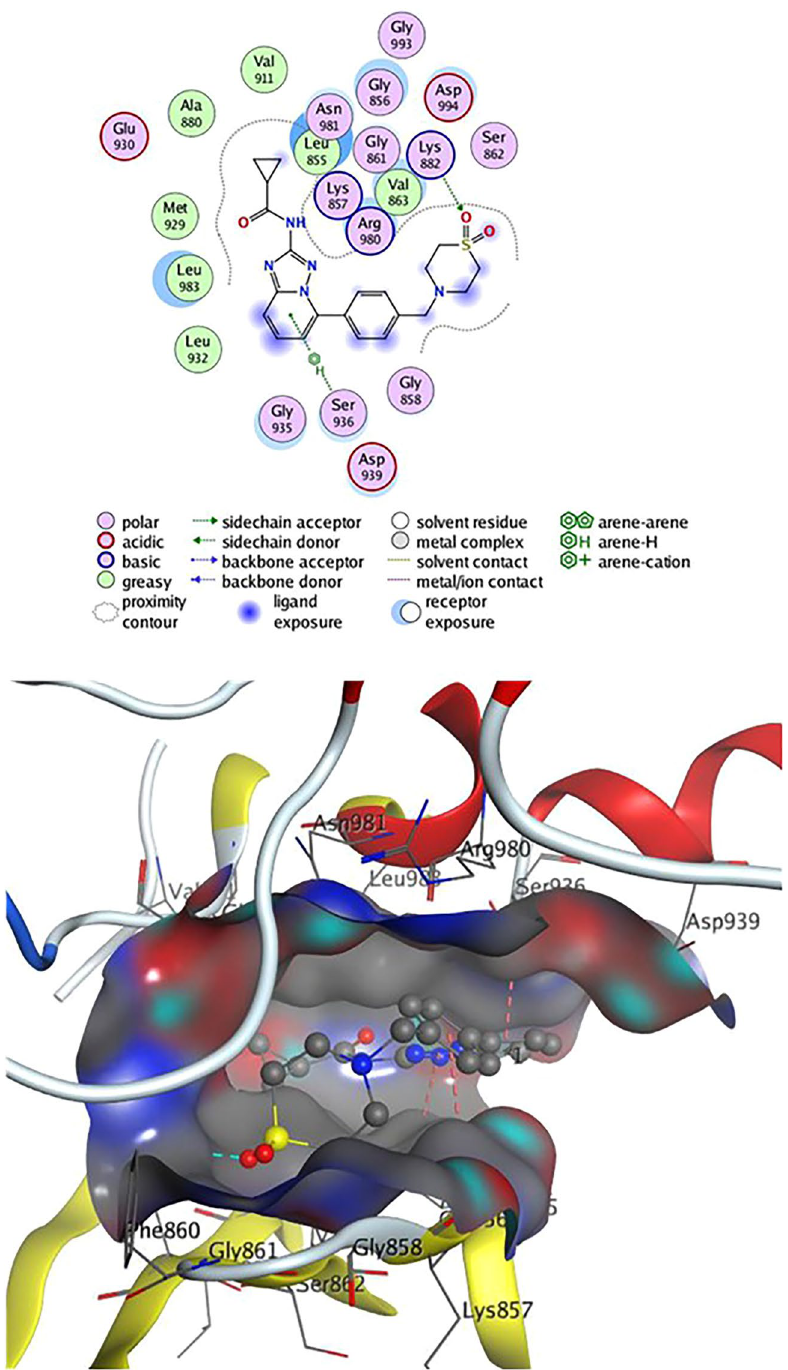
Figure 6. 2D& 3D interaction of 2HB in the active site of Janus kinase Jak2 (PDB ID: 4P7E ). Hydrogen bonds are displayed in cyan & H-pi-bonds are in dark